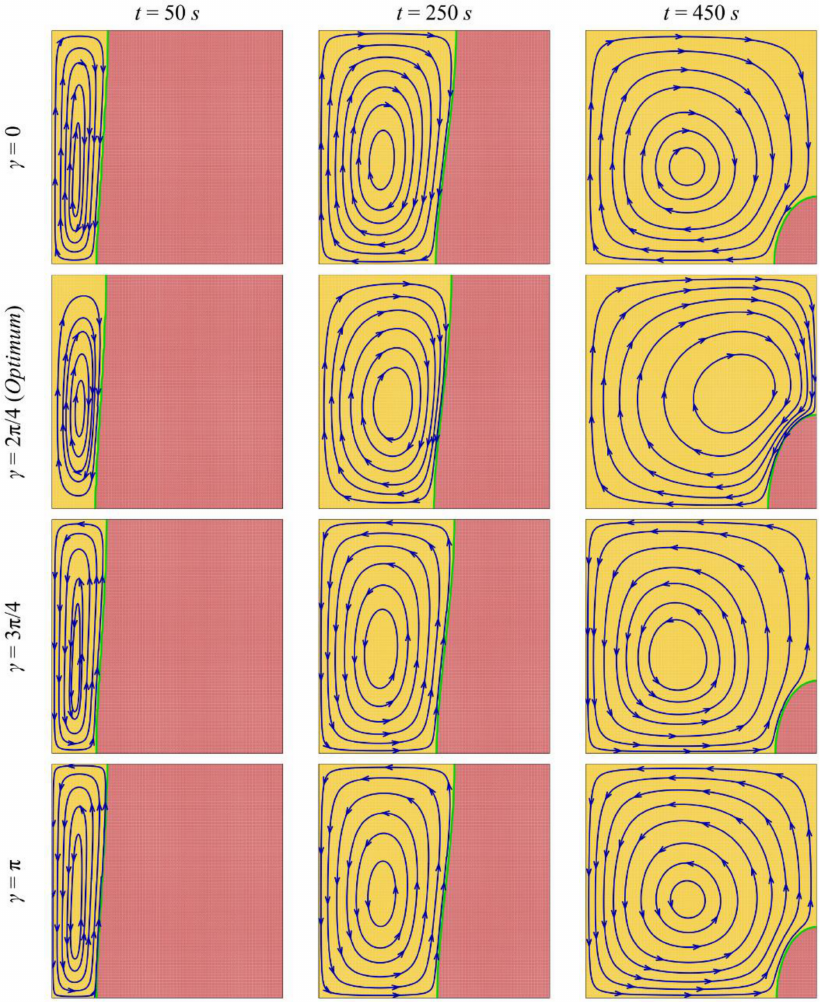
Figure 11. Stream lines and melting interface (green solid line) at three different times for various inclination angles of the enclosed medium when VF na = 0.01, ε = 0.800, a = − 2, and PPI =